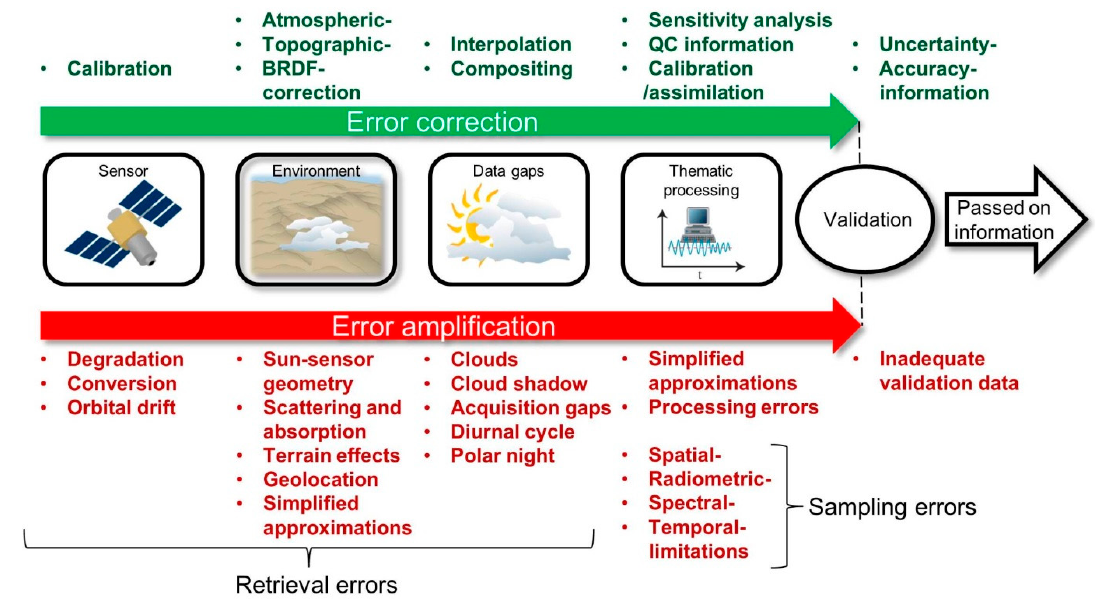
Figure 4. Error sources and corresponding corrections in the generation of earth observation